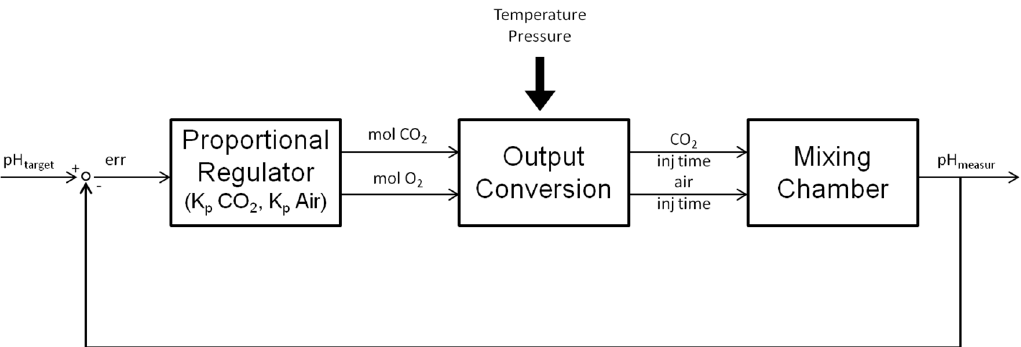
Figure 2. Block diagram for the pH control algorithm in SUITE.